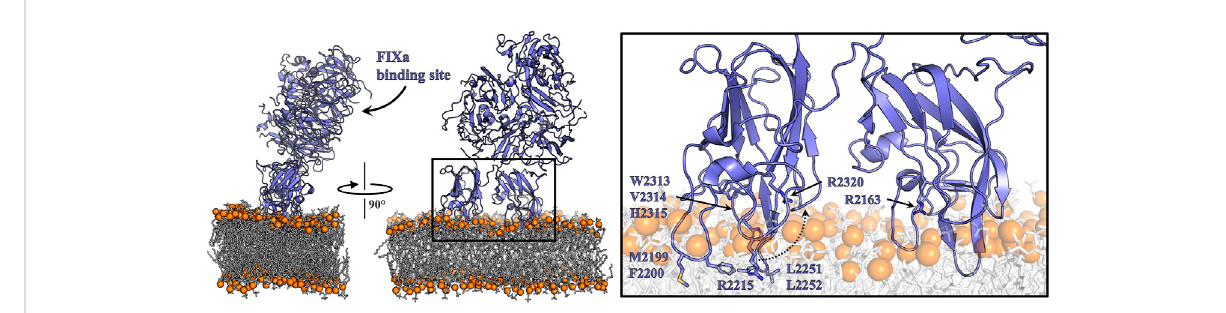
FIGURE 7 Model of membrane-bound fVIII. Human fVIII (slate) was modeled on a bilipid membrane composed of negatively charged phosphate headgroups(orange)andhydrophobicfattyacidtails(white).InsetdepictsfVIIIaminoacids(sticks)whichanchorthecofactortothelipidmembrane. Dashed arrow illustrates the predicted conformational rearrangement to residue R2215 to bind to the negatively charged PS